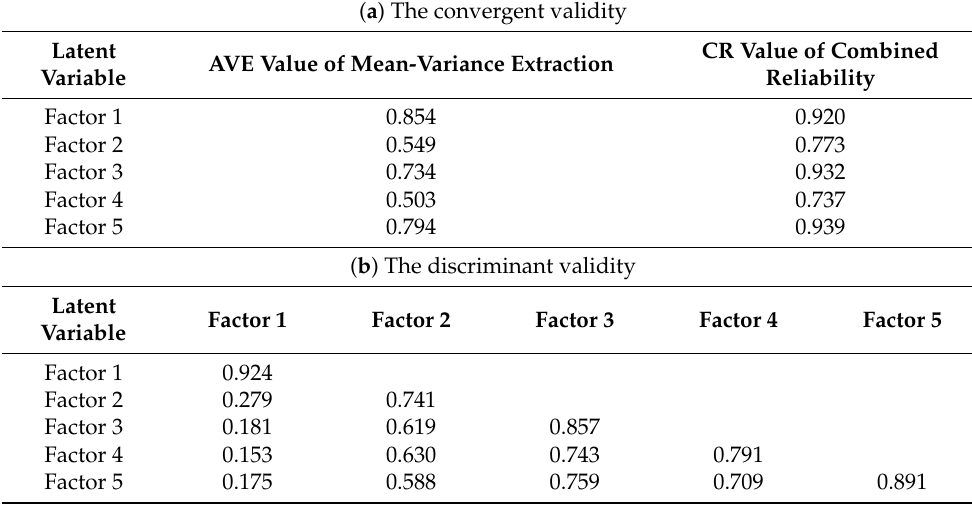
Table 9. The convergent validity and discriminant